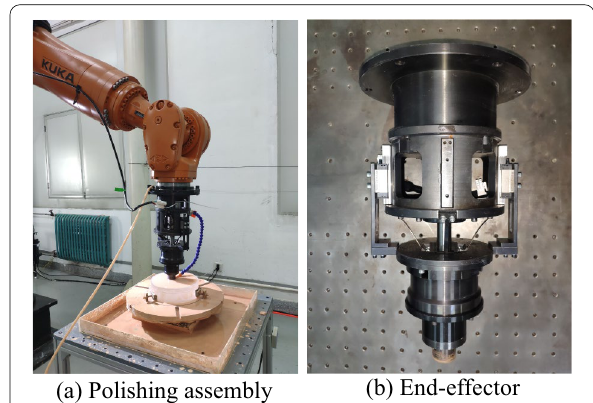
Figure 7 Experimental setup of robotic polishing